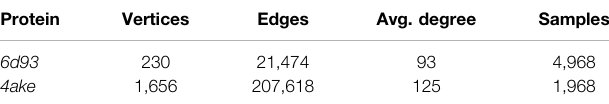
TABLE 3 | Basic statistics of the data sets fed to the machine learning model. For each protein, we report the number of vertices (i.e., heavy atoms) in its graph representation, the total number of edges connecting them, and the average number of edges per vertex (Avg. degree). We also report the total number of CG representations of known mapping entropy provided in input to the protocol (Samples), including random and optimized ones.